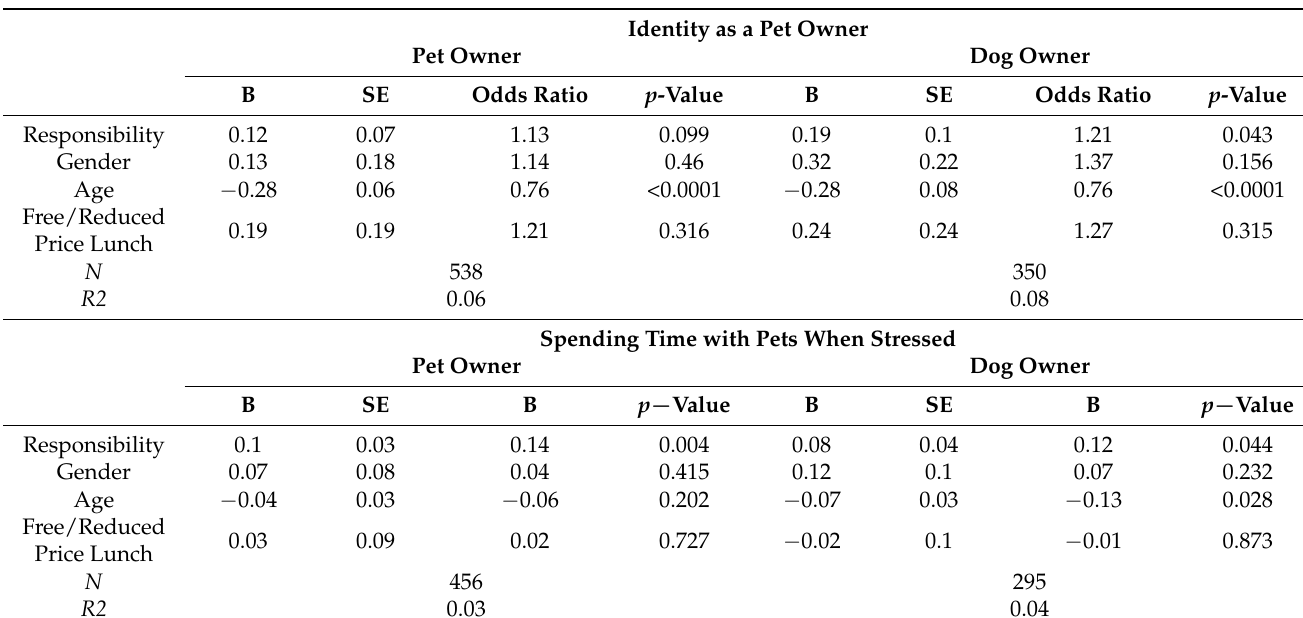
Table 2. Results of Regression Analyses for Pet and Dog